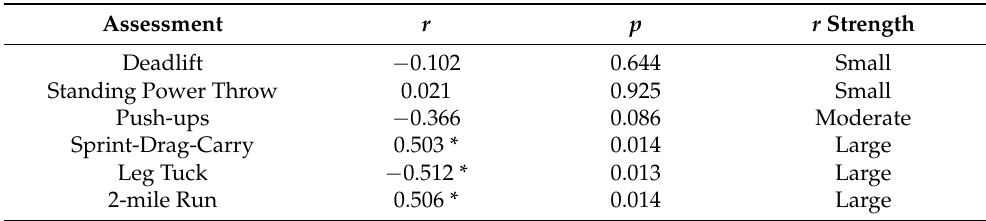
Table 4. Partial correlations (controlling for sex) with tactical foot march and Army Combat Fitness Test event (3-repetition maximum deadlift (deadlift), standing power throw, hand-release push-ups (push-ups), sprint-drag-carry, leg tuck, 2-mile run, scaled scores and total score in ROTC cadets ( N = 29). Assessment r p r Strength Deadlift − 0.044 0.843 Small Standing Power Throw 0.004 0.986 Small Push-ups − 0.372 0.081 Moderate Sprint-Drag-Carry − 0.463 * 0.026 Moderate Leg tuck − 0.516 * 0.012 Large 2-mile Run − 0.531 * 0.009 Large Total − 0.528 * 0.004